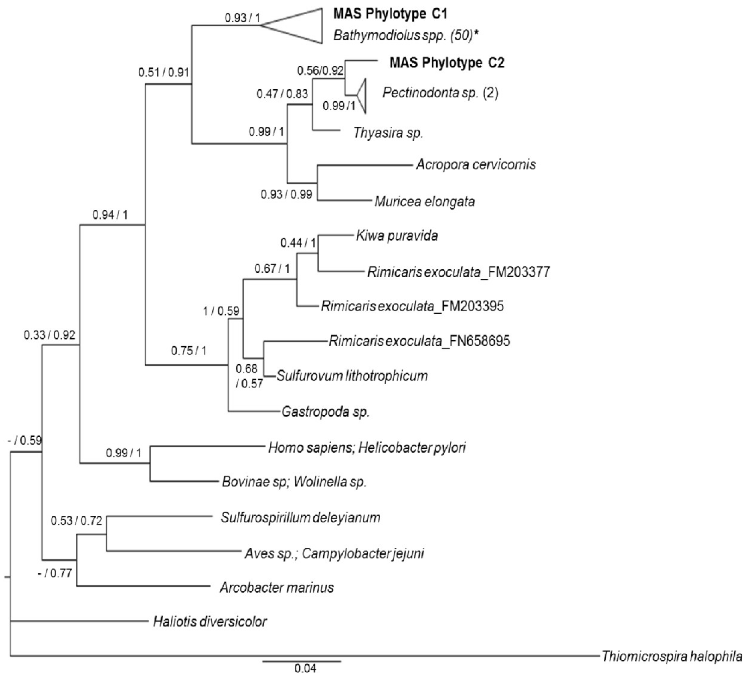
Fig 5. 16S Bayesian phylogram based upon 16S sequences for Campylobacterota. The nodes are labeled with maximum likelihood bootstrap probabilities based on 500 bootstrap replicates before the slash and Bayesian posterior probabilities after the slash. If the node placement did not agree between the two trees, a “-” is indicated before the slash. The branch tips are labeled with the name of the host species. If more than one sequence from that host is represented, the samples size is in parentheses after the name. In cases where the host is not a marine organism, the host and symbiont are both listed, separated by a semi-colon. Sulfurovum lithotrophicum , Arcobacter marinus , and Sulfurospirillum deleyianum were collected from sediment. S8 Table contains Genbank accession numbers of individuals in the trees. Phylotypes C1 and C2 are in bold. � The clade including C1 also includes symbionts isolated from Bathymodiolus azoricus , B . childressi , B . manuensis , B . mauritanicus , B . sp . 9 South, and B . sp . Pakistan.